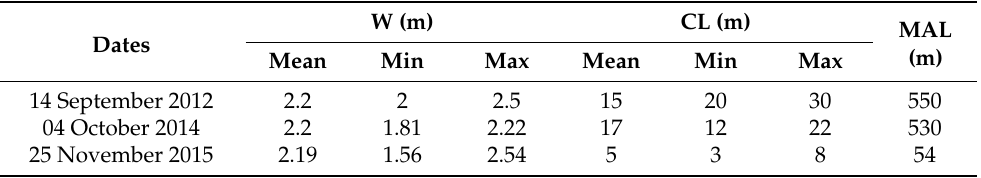
Table 2. Characteristics of the rhythmic features in the Google Earth imagery (W = wavelength, CL = cross-shore length, MAL = mean along-shore length).